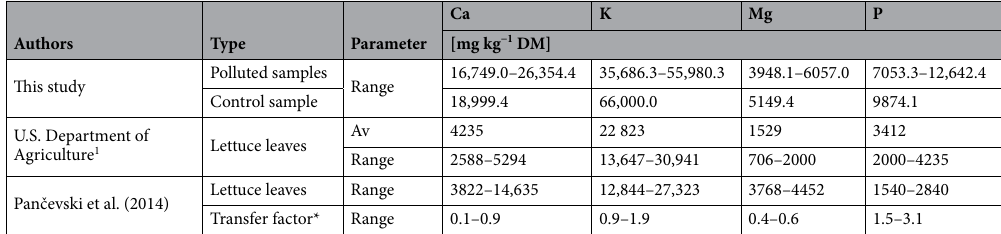
Table 5. The content of macroelements in lettuce leaves—a literature review. 1 fresh mass converted by dry mass using the conversion factor of 0.085; *data calculated; “– “ lack